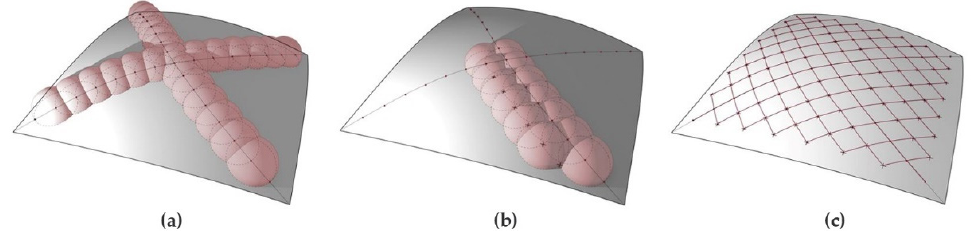
Figure 7. Compass Method: ( a ) Initial curves subdivision; ( b ) Surface subdivision process; ( c ) Resulting mesh.